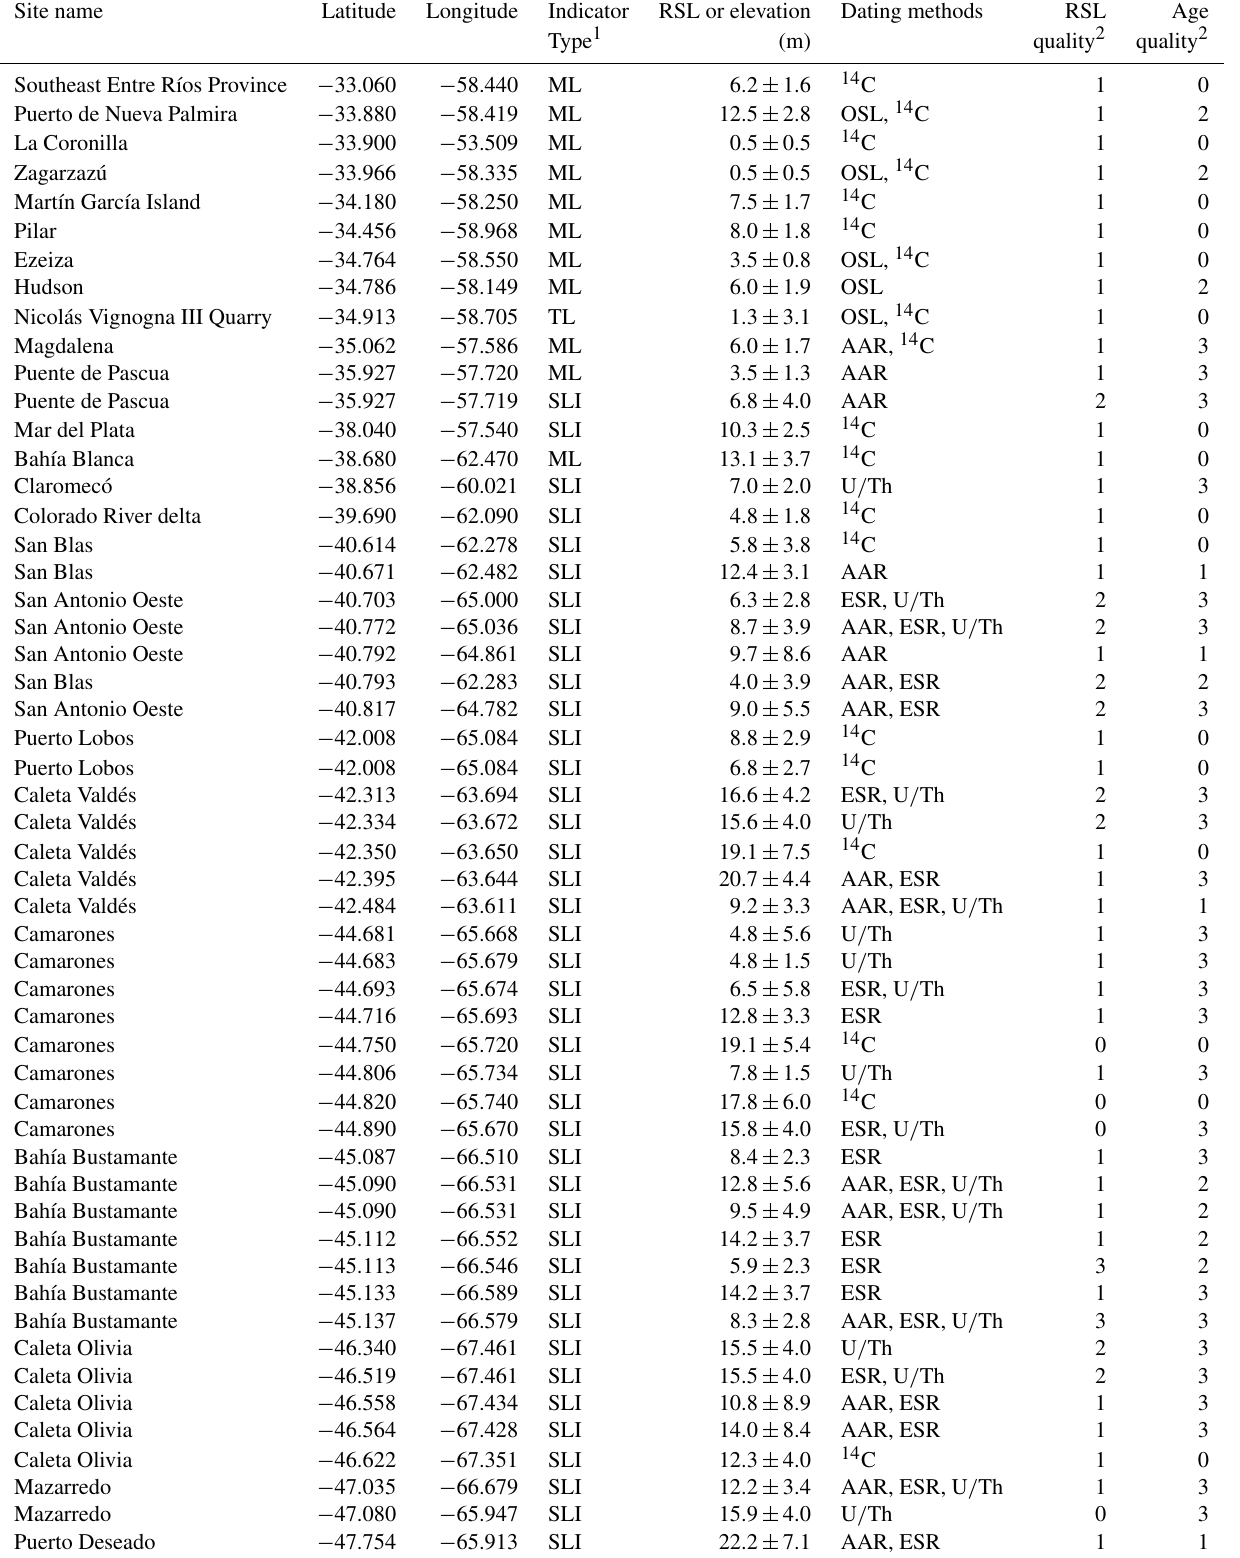
Table 3. Summary of reviewed inferred MIS 5 sea-level data. For references refer to the